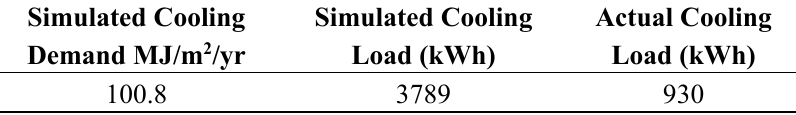
Table 6. Simulated and actual cooling loads.